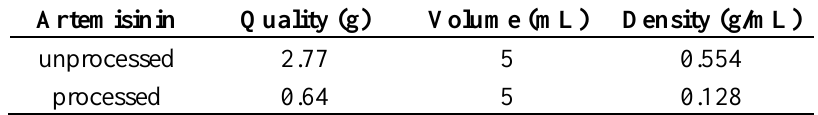
Table 3. The comparation of bulk density between unprocessed and processed